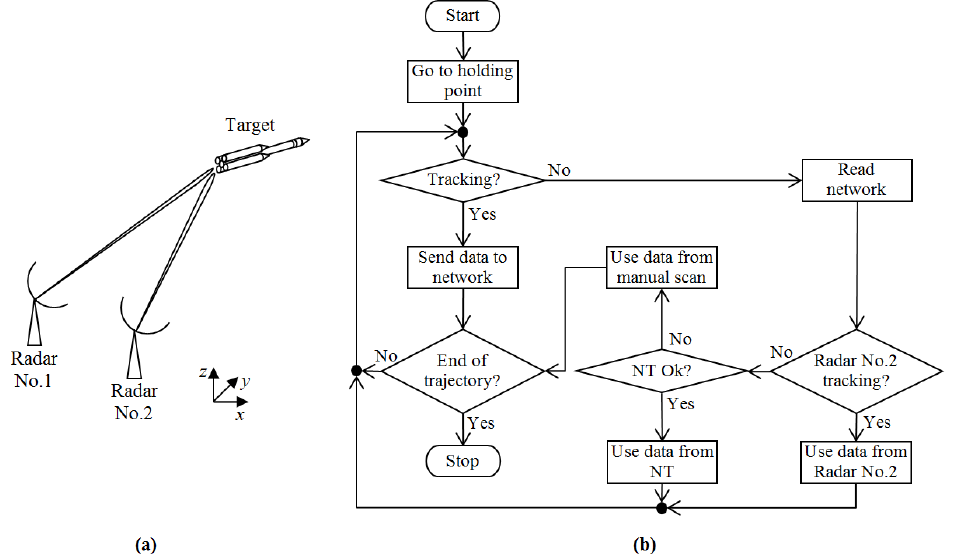
Figure 3. ( a ) Rocket Tracking System (RTS) with two radar sensors. ( b ) Flowchart of operation of the Radar